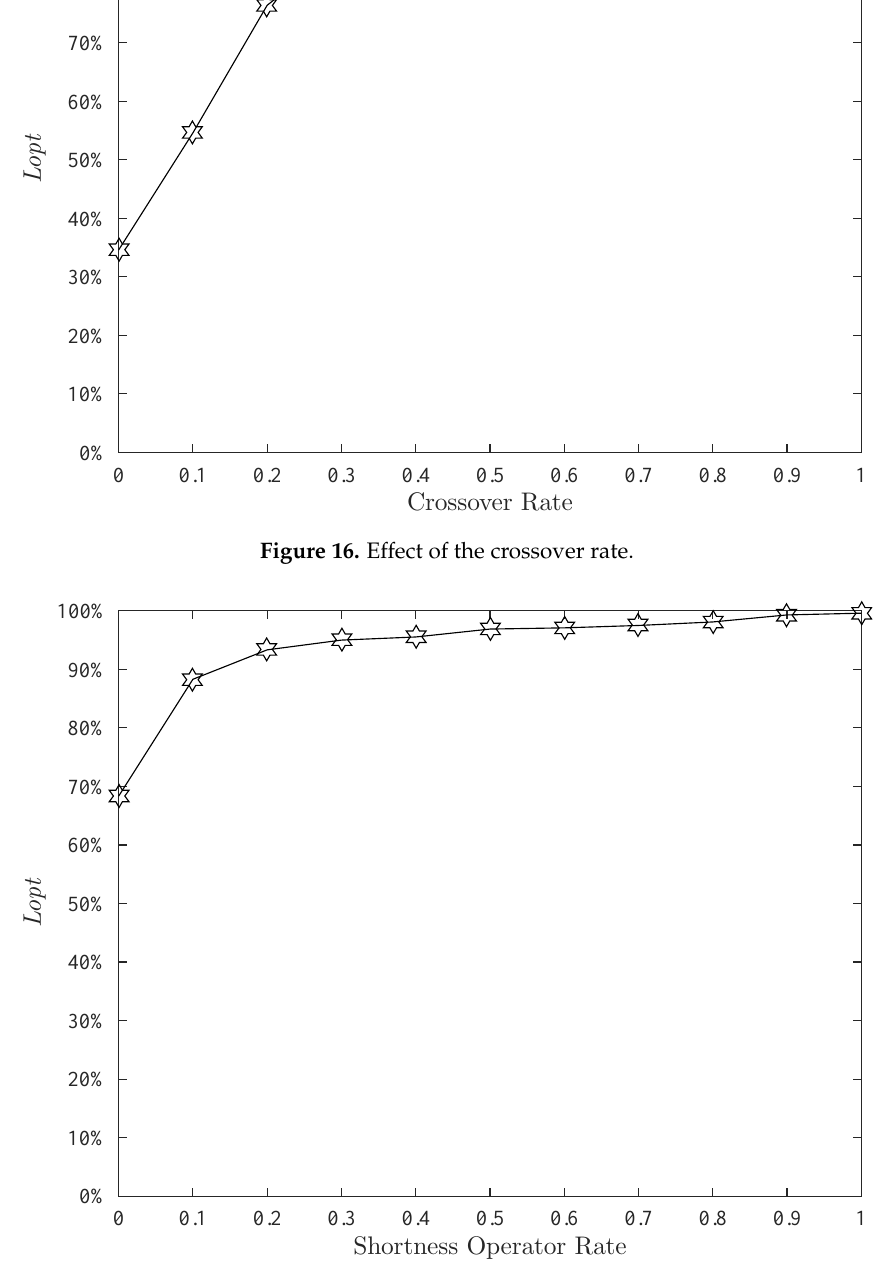
Figure 17. Effect of the shortness operator